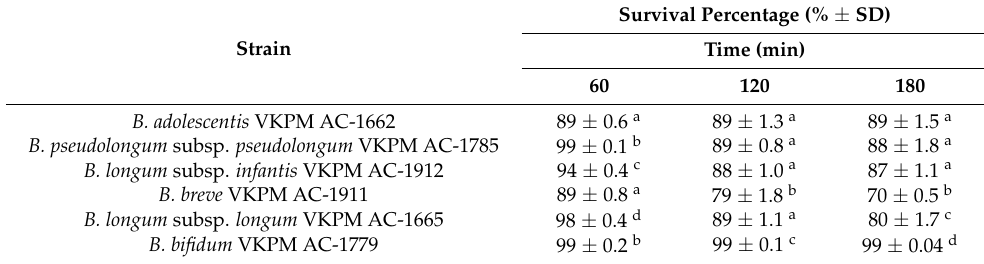
Table 8. Tolerance of Bifidobacterium strains to bile.